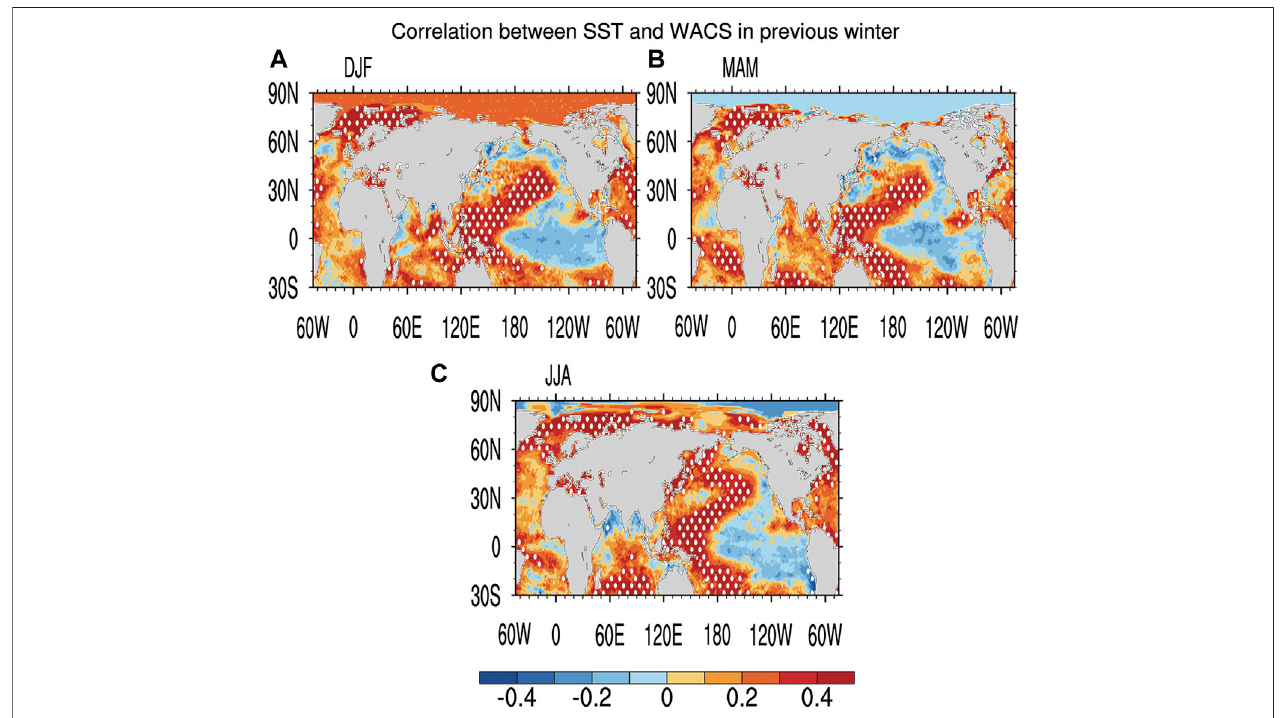
FIGURE 10 | Distribution of the correlation coef fi cients between the WACS index and the SST in the time period 1979 – 2020 in (A) previous winter, (B) spring and (C) summer. The white dots indicate statistical signi fi cance at the 95% con fi dence level.